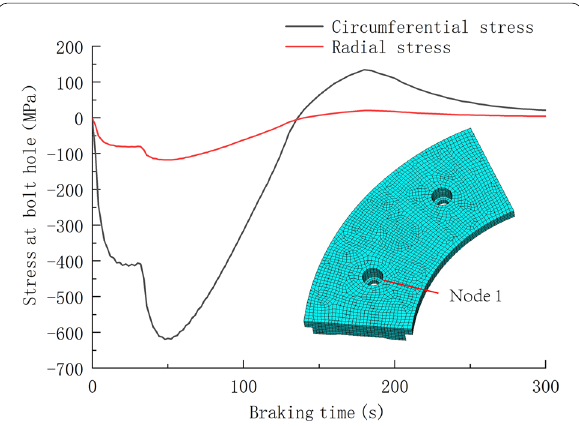
Figure 9 Circumferential stress and radial stress at bolt hole